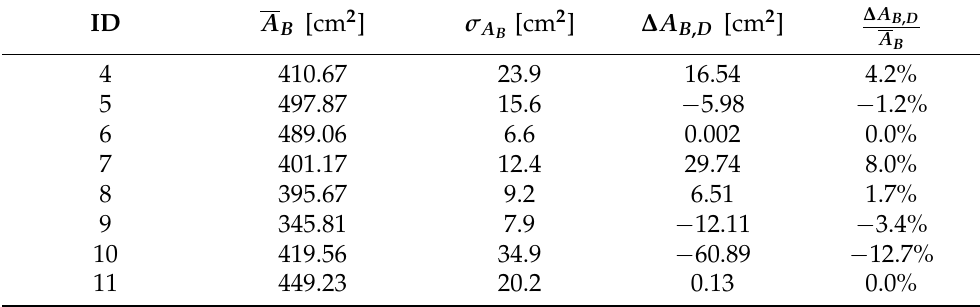
Table 4. Averaged leaf areas A B over the time series of plant p 1_ e , acquired by the MSS as well as differences ∆ A B , D between the B-spline based leaf area determination and the digitizer results.